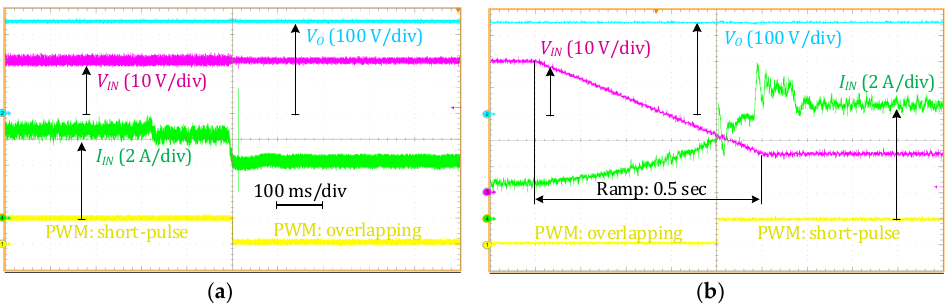
Figure 15. The converter operation with a closed-loop control system in the cases of: ( a ) a load step-change; ( b ) an input voltage ramp-change.